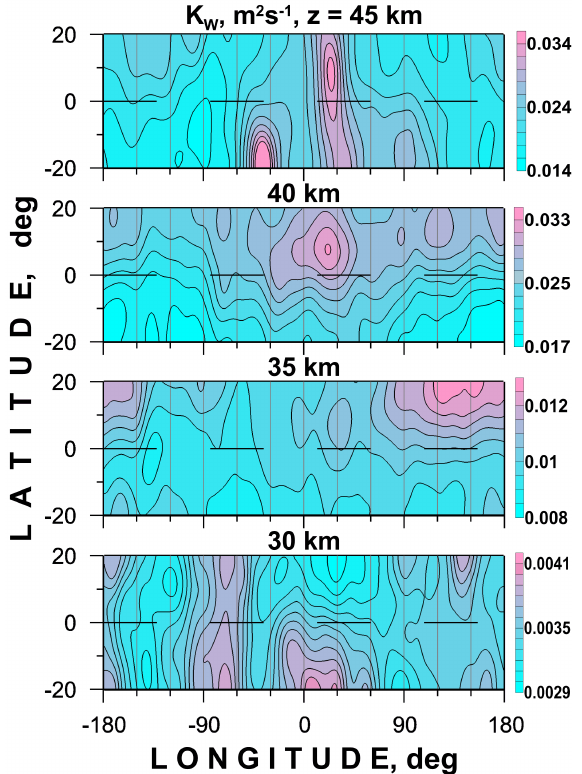
Fig. 4. Latitude-longitude distributions of turbulent diffusivity esti- mate K W in September–November 2004 at different altitudes.